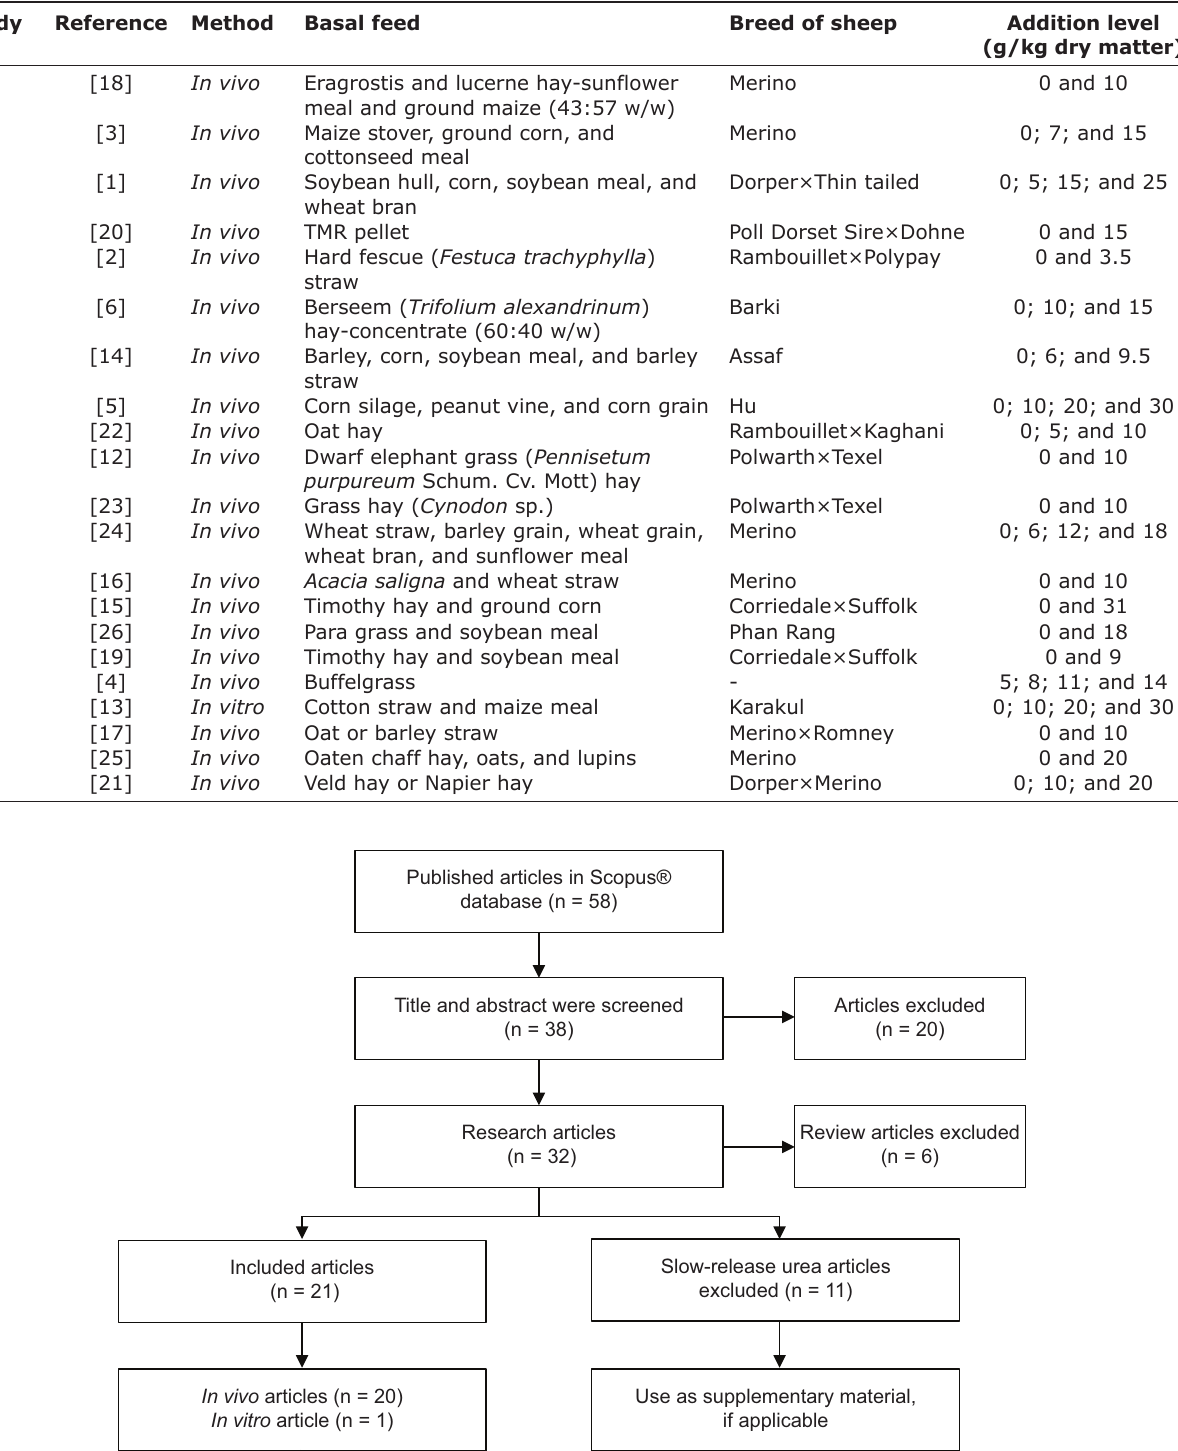
Table-1: Experiments included in the meta-analysis of the effect of urea supplementation on rumen fermentation and sheep performance. Study no.